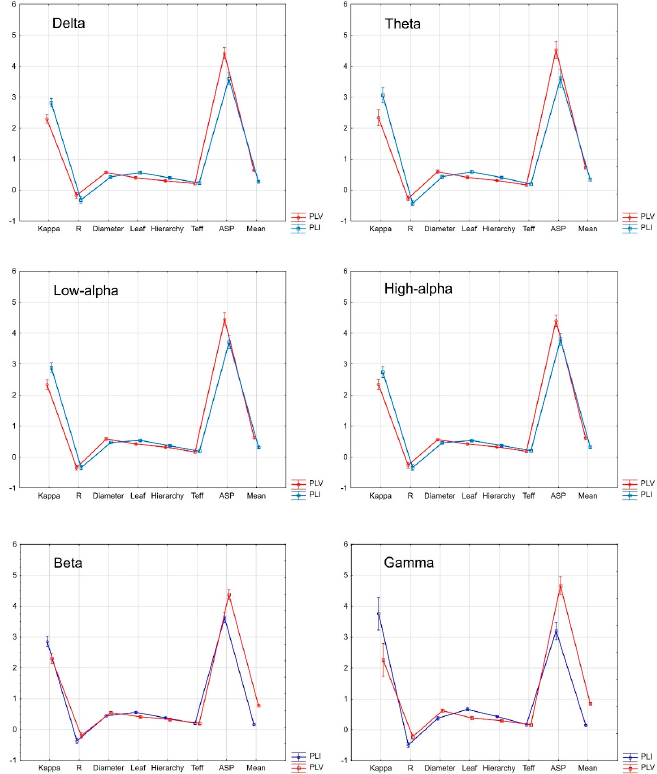
Figure 3. Within-group comparisons of MST indicators (kappa, R, diameter, leaf, hierarchy, Teff, ASP, and mean) based on PLI (blue curve) and PLV (red curve) FC strength indicators in the HC group. The vertical bars represent 0.95 confidence intervals. Comparisons were selectively computed for individual frequencies.